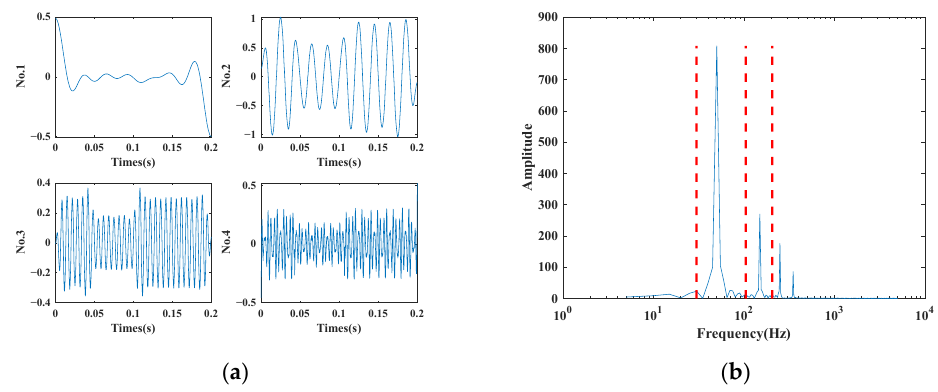
Figure 6. PQD signal decomposition results by EWT when K = 4. ( a ) Results in the time domain; ( b ) Segmented spectrum.